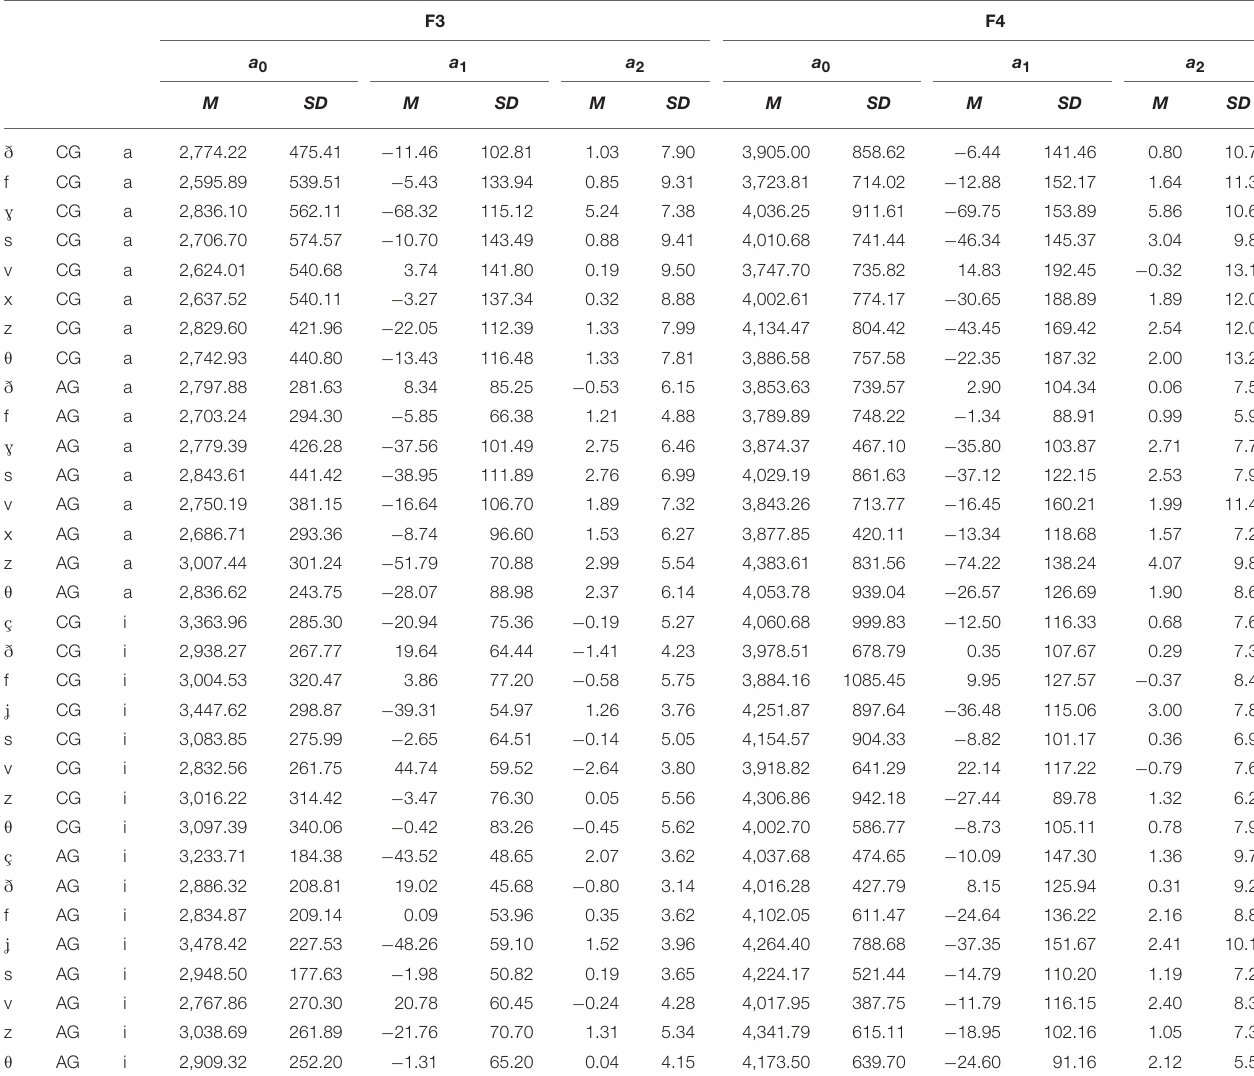
TABLE 7 | Mean and SD of a 0 , a 1 , a 2 polynomial coefficients of the formant frequencies F 3, and F 4 of vowels /a/ and /i/ as a function of fricatiVe consonant and dialect [Athenian Greek (AG) and Cypriot Greek